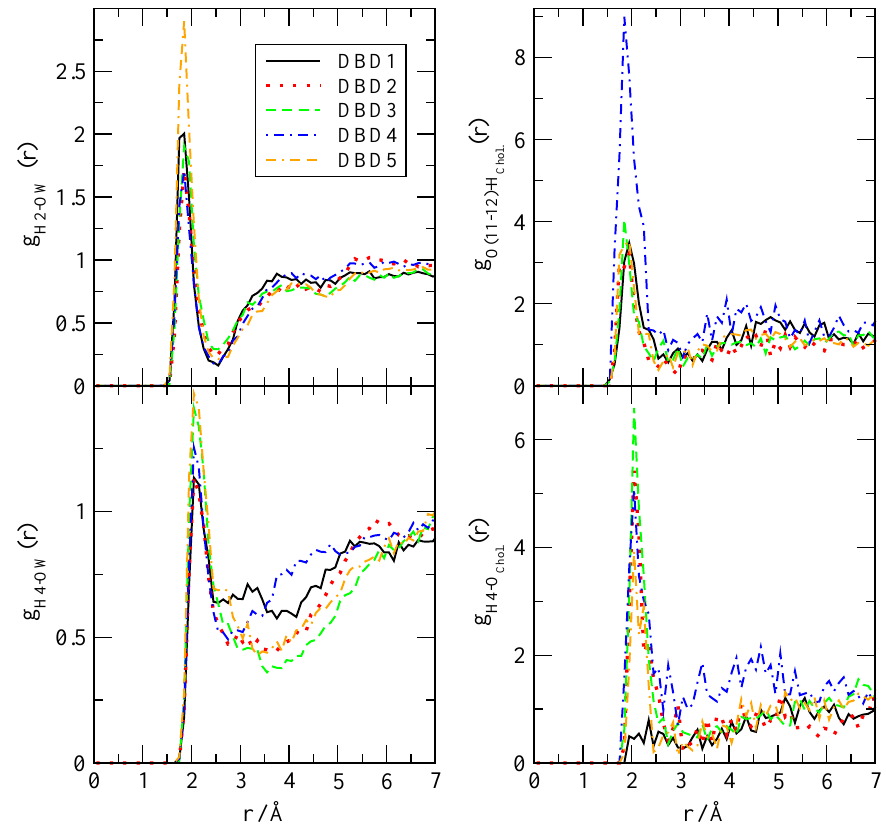
Figure 5. Radial distribution functions between sites ‘H2’ and ‘H4’ of DBD derivatives and selected sites of water (left column) and cholesterol (right